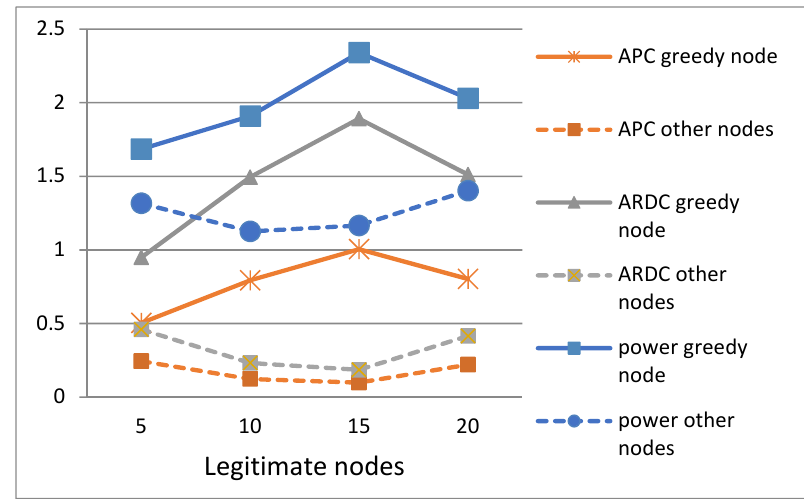
Figure 6. Power, APC, and ARDC of greedy and legitimate nodes.